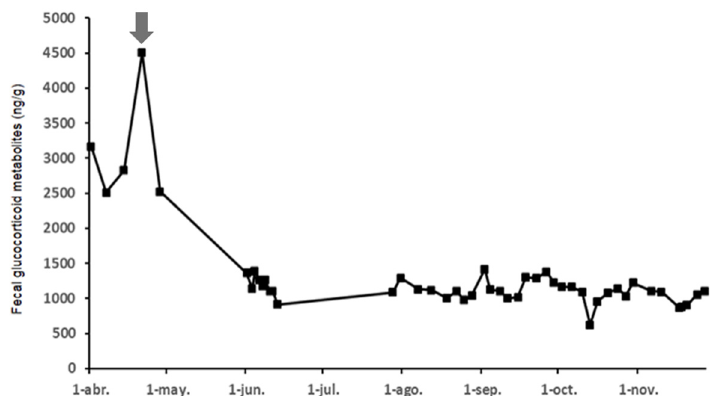
Figure 2. Hormonal profile of fGCM (ng/g) before, during and after giving birth in Female 1. The arrow points to the moment of partum. The hormonal peak was reached just before parturition (fGCM = 4502.7 ng/g).